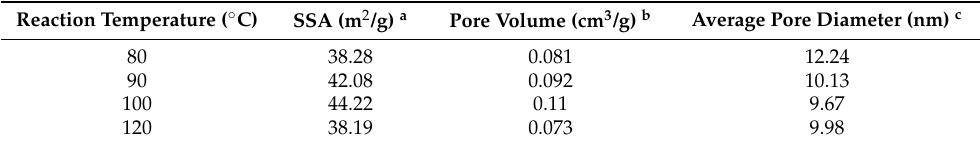
Table 4. BET/BJH results of the materials synthesized at the different reaction